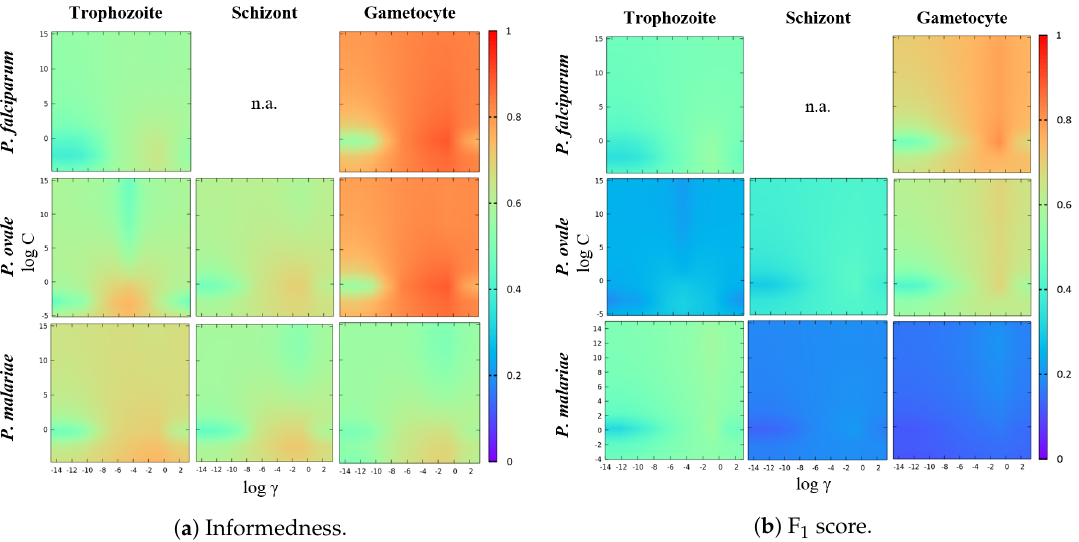
Figure 13. Heat maps of the SVM parameters’ selection process for each species-stage